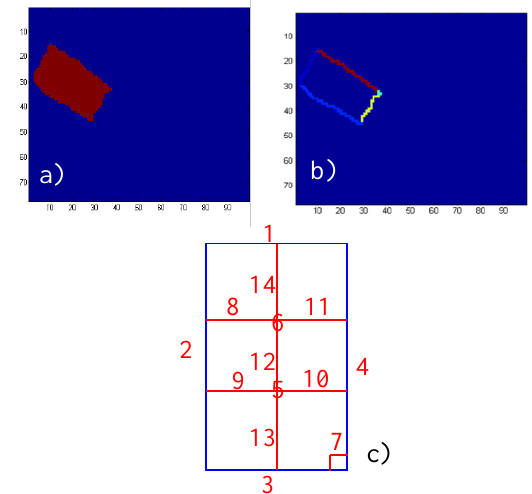
Figure 4. Calculation of boundary_enveloping _ plane matrix a) b_plane matrix of the plane N°2; b) boundry_enveloping